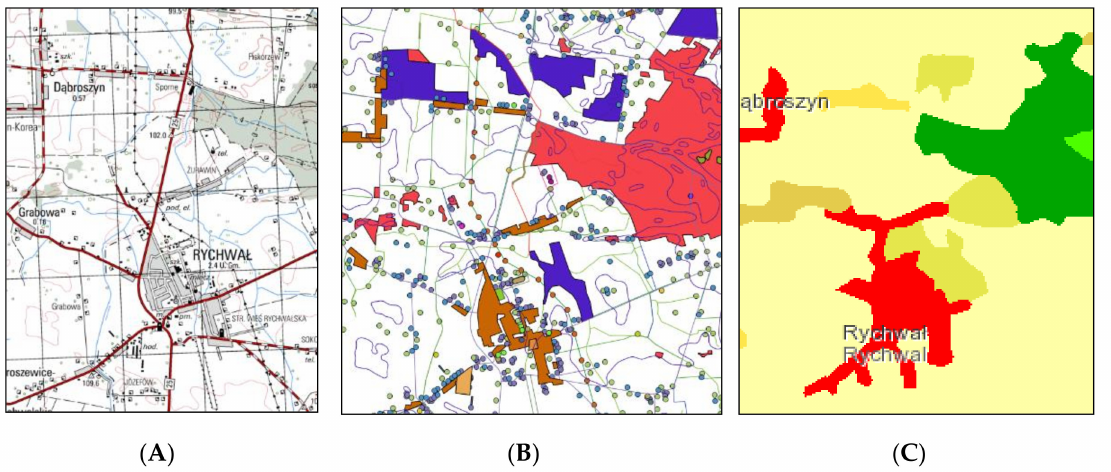
Figure 2. Comparison of the visualization of used data: ( A )—topographic map in the scale of 1:50,000, ( B )—Vector Map Level 2, ( C )—Corine Land Cover